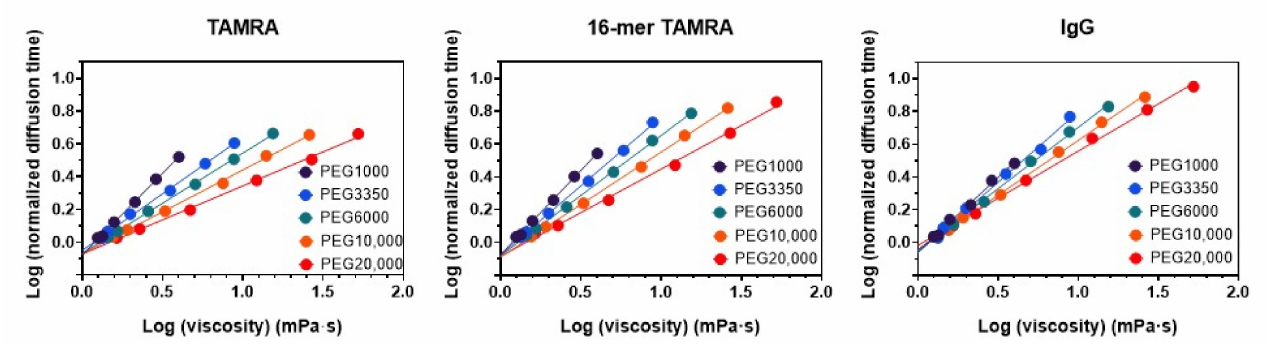
Figure 3. The measured di ff usion times ( τ D ) depend on macroviscosity ( η macro ). The relationships between the normalized solute τ D s and solvent η macro s are shown with both logarithmical axes for TAMRA, 16-mer TAMRA and IgG.